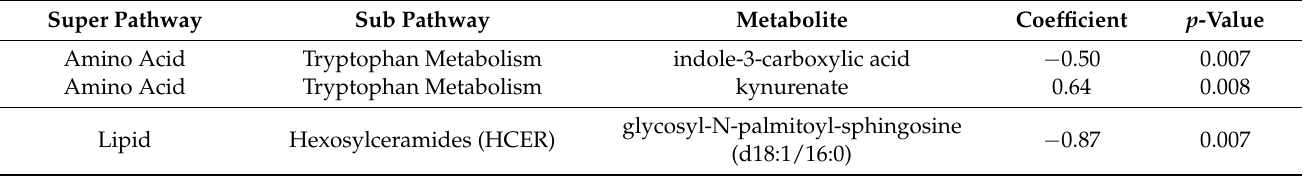
Table 4. Metabolites associated with AUDAC for patients with RIT > 20 min ( p -value < 0.01).